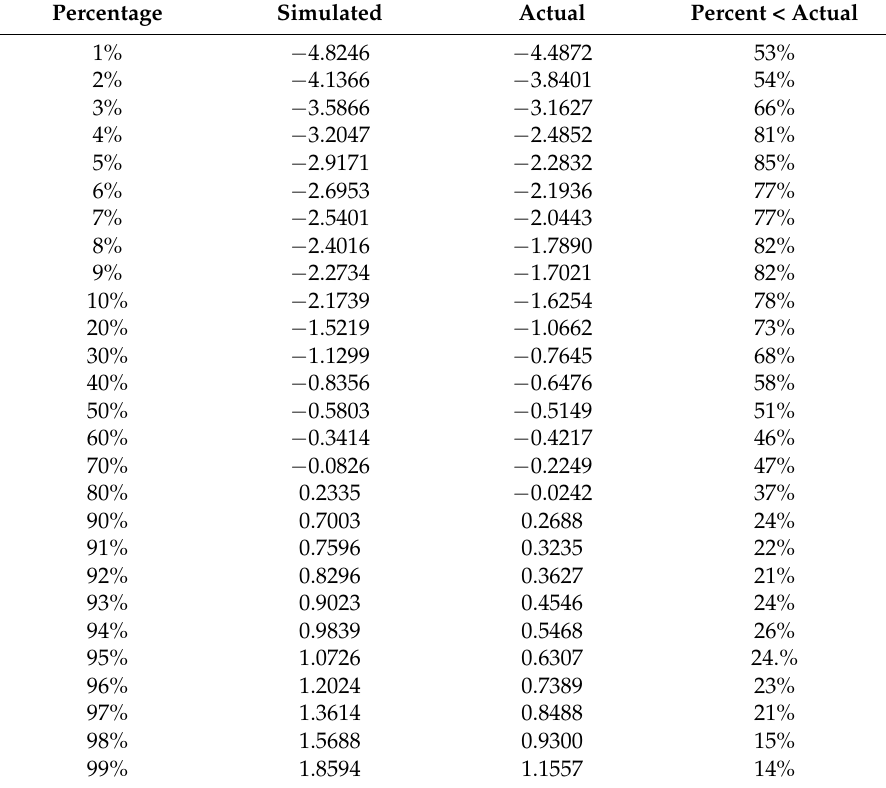
Table 4. Comparison of the actual and simulated t -alpha for Japanese Mutual Funds using the t -alpha Fama and French (2010) bootstrap